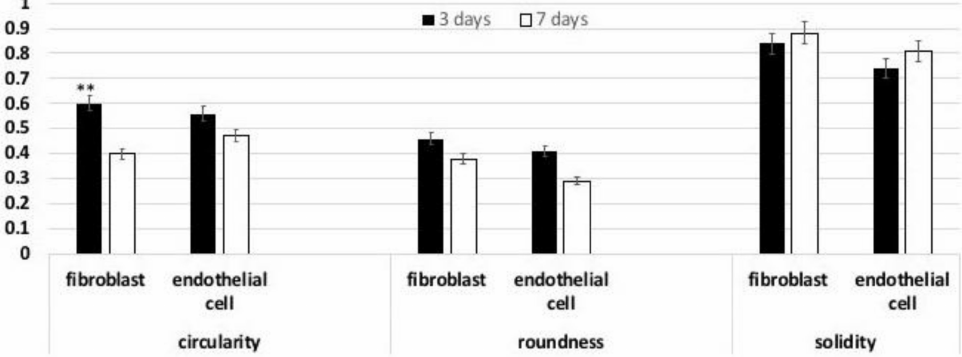
Figure 3. Analysis of the Circularity; Roundness; and Solidity cell shape parameters after 7 and 14 days of culture onto the control and VEGF-enriched implants. ** p < 0.05.